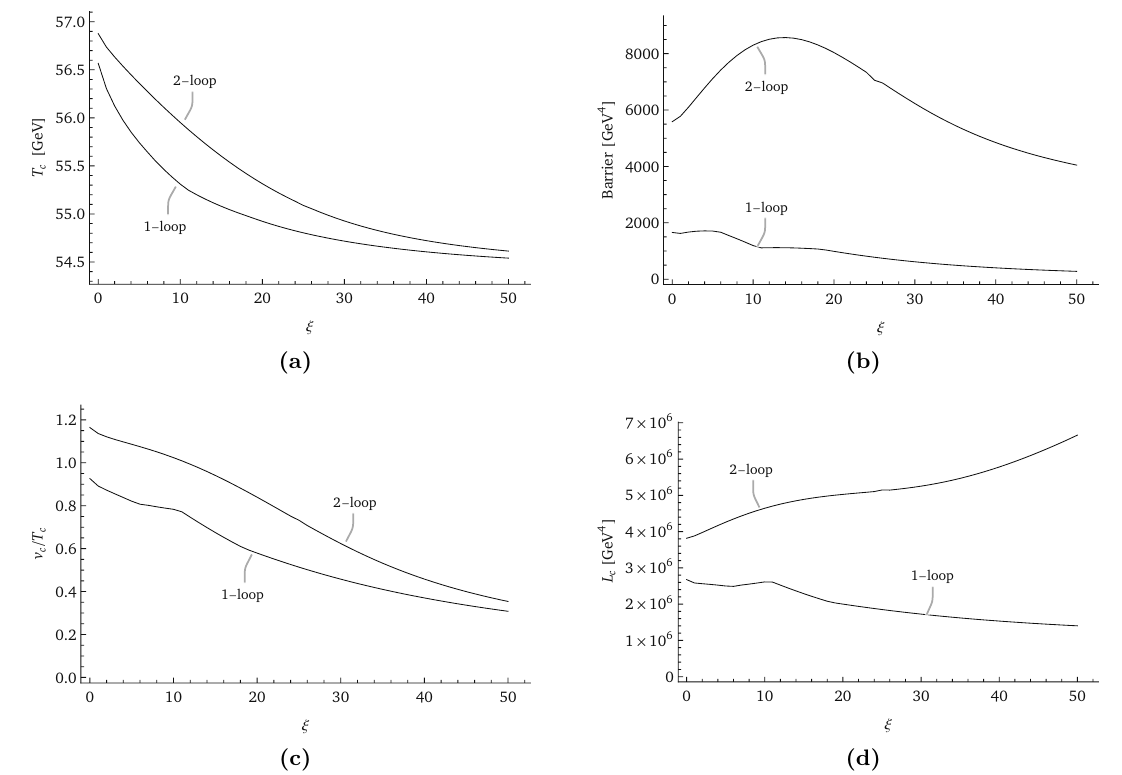
Figure 1 . Observables at T c in the traditional method for a specific mass m H = 45 GeV , versus the gauge-fixing parameter ξ , of (a) the critical temperature, (b) the barrier height, (c) the phase transition strength, and (d) the latent